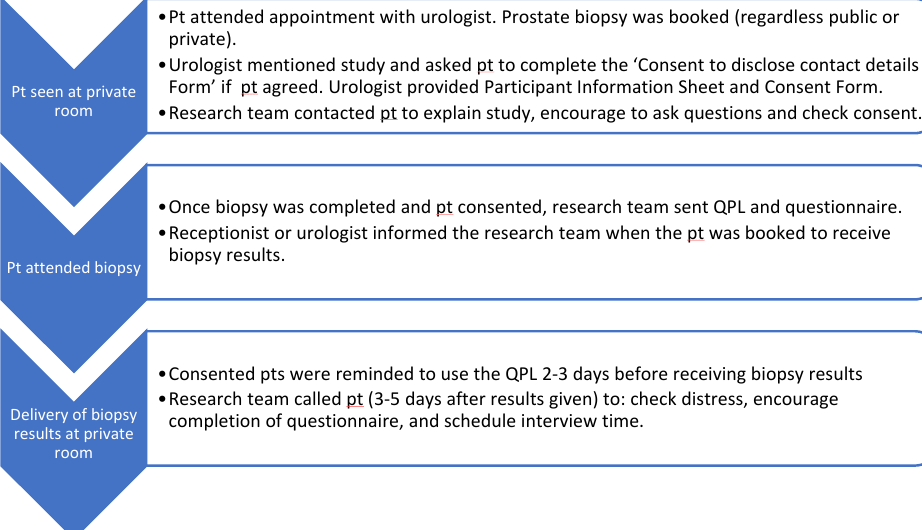
Figure 1. Study procedure. Pt, patient; QPL, question prompt list.